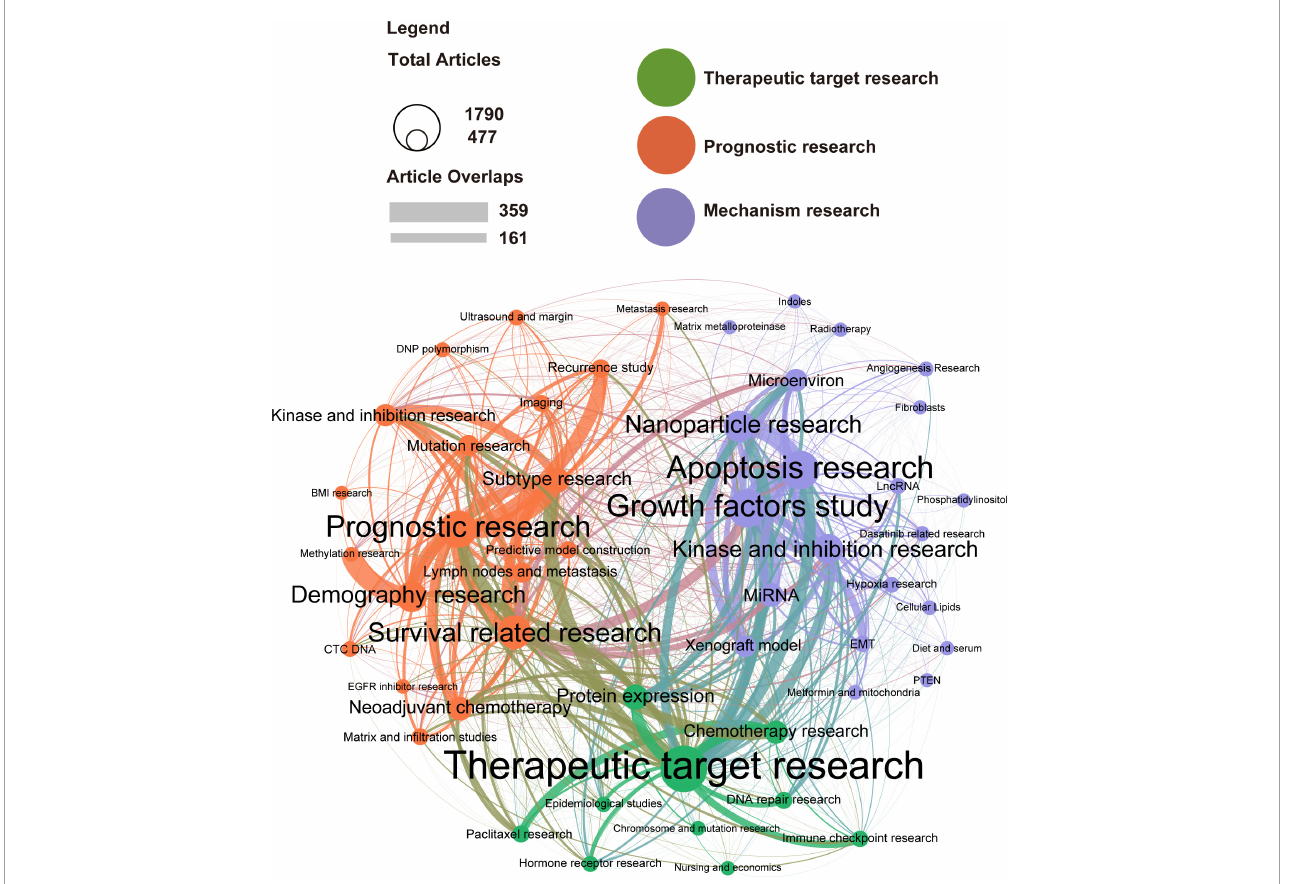
FIGURE5 Latent Dirichlet Allocation (LDA) identified that the triple-negative breast cancer (TNBC) research is focused on three areas Therapeutic target research, Prognostic research, and Mechanism research. Topic cluster network studied by Latent Dirichlet Allocation: inter-and intra-relationships. Therapeutic target research (green), Prognostic research (orange), and Mechanism research (purple) are three major clusters in TNBC research. The circle size represents the number of publications on each topic; the line’s thickness represents the weight of the connection between each